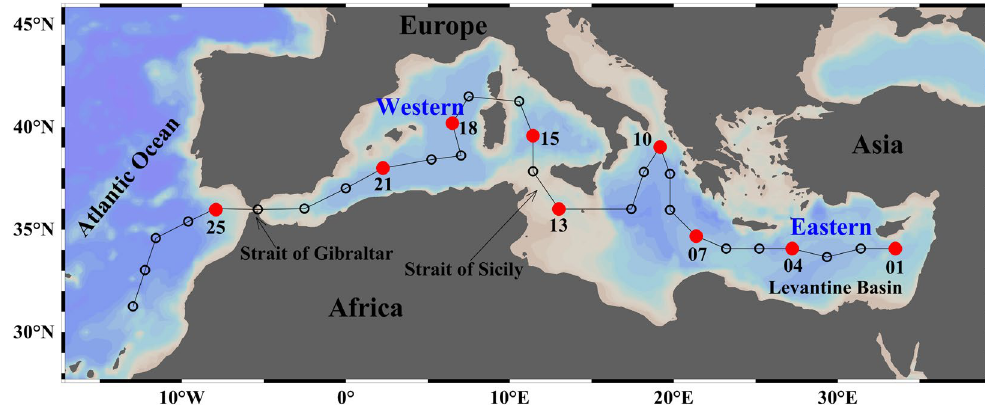
Figure 1. Map of the study area and sampling stations during the HOTMIX cruise. Open circles indicate all stations sampled during the cruise and solid red circles represent the stations where samples for DOM size- fractionation were taken. Figure created using Ocean Data View (Schlitzer, R., Ocean Data View, odv.awi.de,